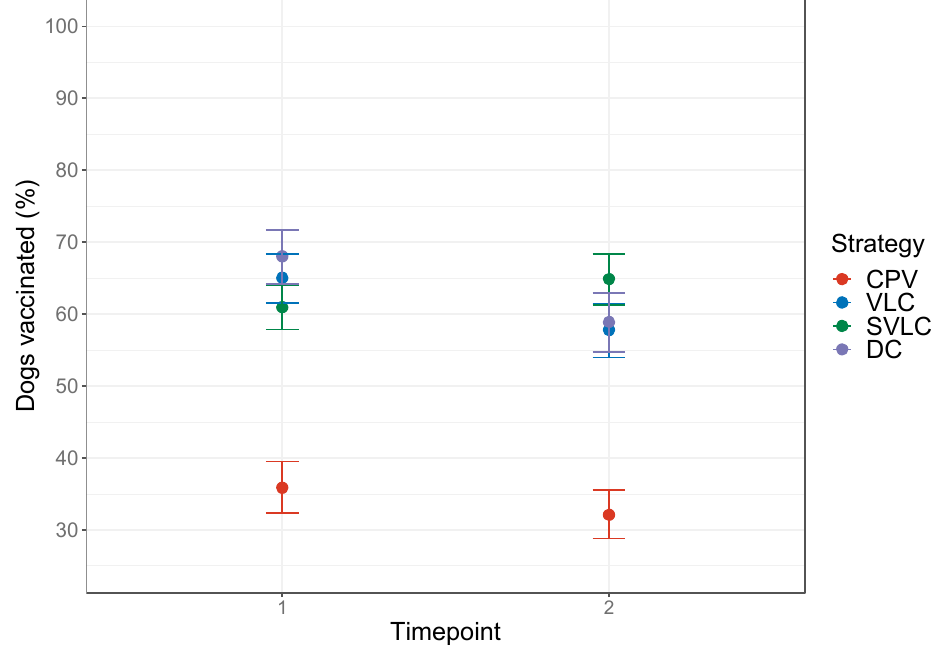
Figure 3. Vaccination coverage attained in each strategy at month 1 and month 11 post vaccination. Coverage was estimated from the number of dogs with microchips out of all dogs recorded as living at surveyed households. CPV = centralized pulsed vaccination, VLC = village-level continuous decentralized vaccination, SVLC = sub-village level continuous decentralized vaccination, DC = discretionary continuous decentralized vaccination.